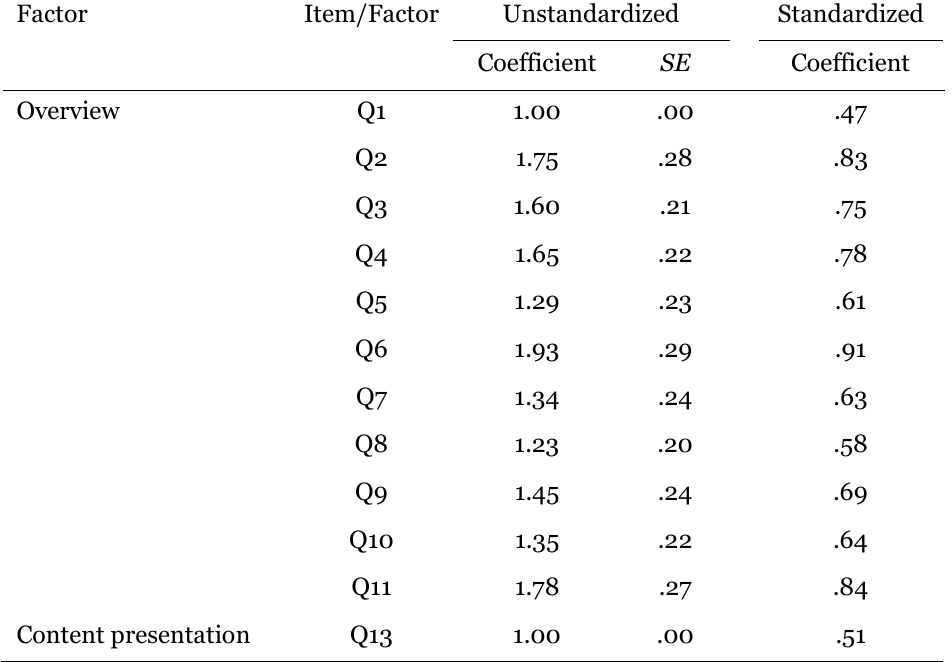
Unstandardized, Standardized Pattern Coefficients, and Standard Error (SE) for the Higher-Order Model